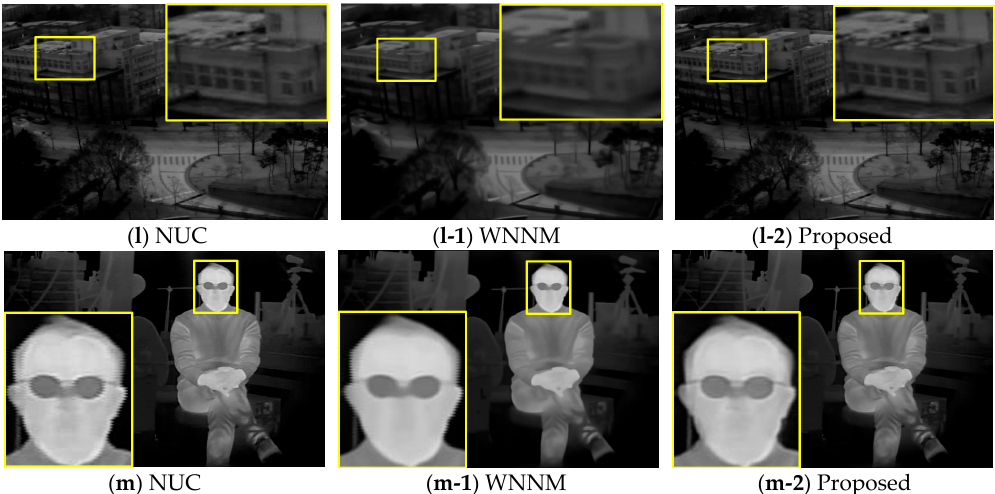
Figure 11. NUC, WNNM and proposed BRANF applied on MWIR, LWIR images with various types of noises: ( g , h ) moving oblique line noise; ( i – k ) LTV vertical line noise; ( l ) little noise case; ( m ) nonfixed jitter noise. (Experimental data set 2).